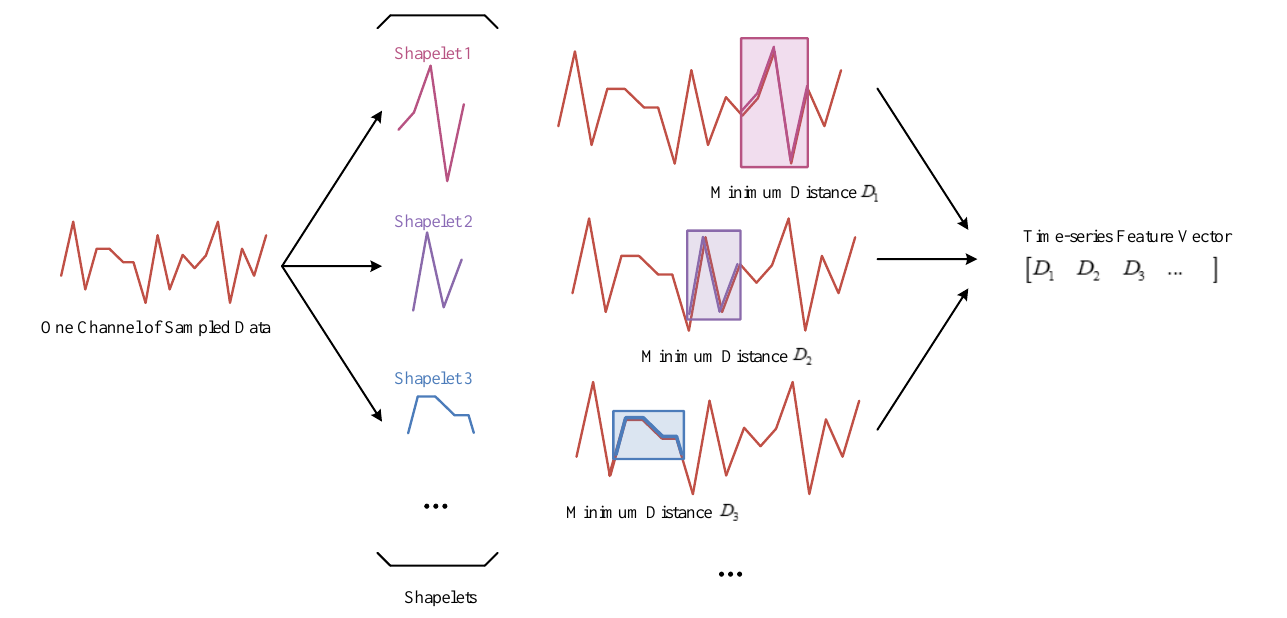
Figure 5. Time-series features extraction from Shapelet Transform